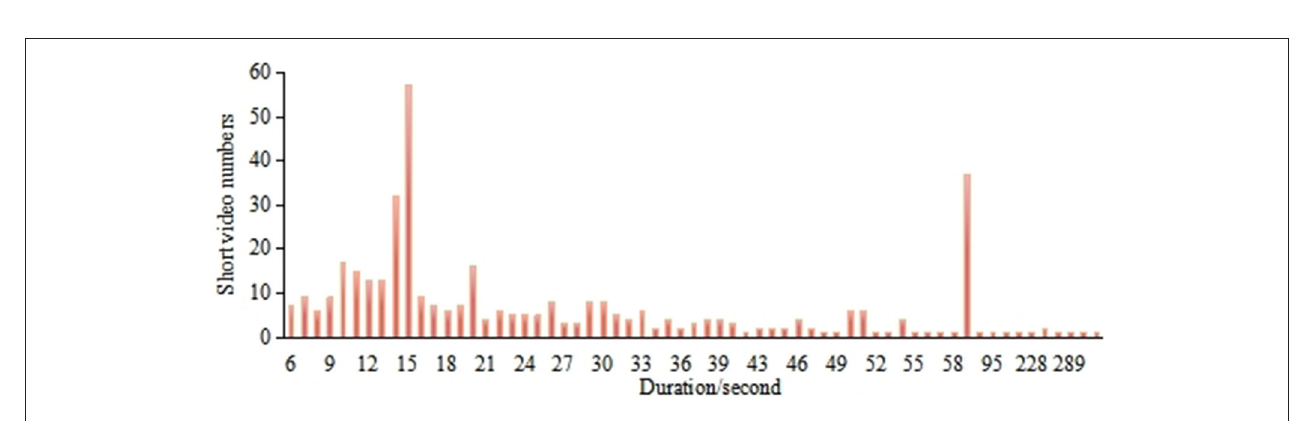
FIGURE 7 | Changes in duration of short fitness videos on TikTok.